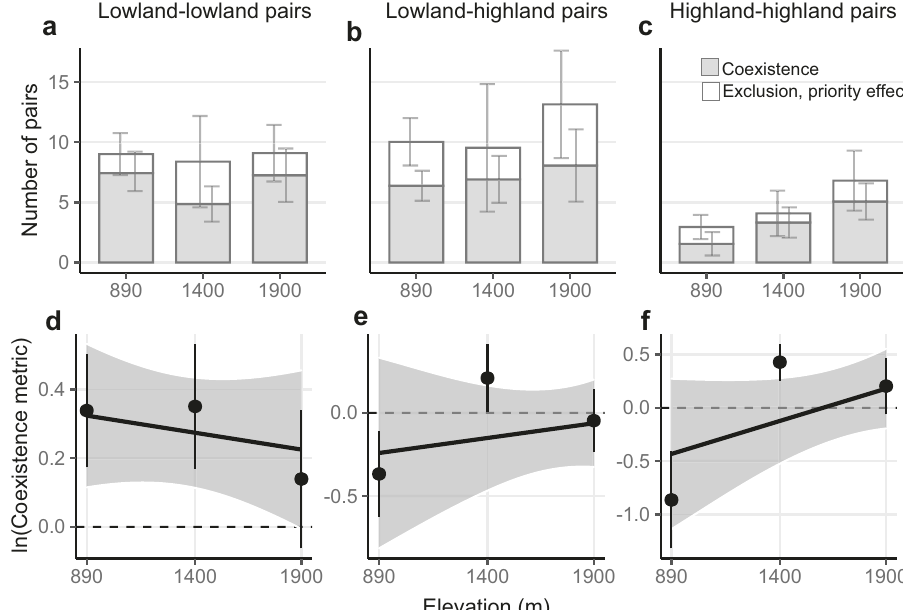
Fig. 2 Competition outcomes across the elevation gradient. The estimated competitive outcomes ( fi rst row) and strength of coexistence (i.e. coexistence metric, log-transformed; second row) across the elevation gradient of lowland – lowland ( a , d ; n = 9, 10, and 10 pairs at the low, middle, and high elevations, respectively), lowland – highland ( b , e ; n = 14, 12, and 18 pairs at the low, middle and high elevations, respectively), and highland – highland species pairs ( c , f ; n = 4, 5, and 8 pairs at the low, middle and high elevations, respectively). In a – c , stacked bars represent the mean number of pairs showing stable coexistence (grey) and competitive exclusion or priority effects (white), with error bars showing 95% con fi dence intervals of each group based on the bootstrap replicates ( N = 500 bootstraps). In d – f , the points and error bars represent the averages and standard errors across species pairs at each site; solid lines indicate a signi fi cant interaction of elevation × competitor identity (test based on the mean of bootstrap replicates; p < 0.05; Supplementary Table 5); shading indicates 95% con fi dence intervals for the regressions derived from bootstrap replicates of the dataset ( N = 500 bootstraps), indicating the propagated uncertainty in the relationships resulting from model parametrization (see Methods). Source data are provided as a Source Data fi